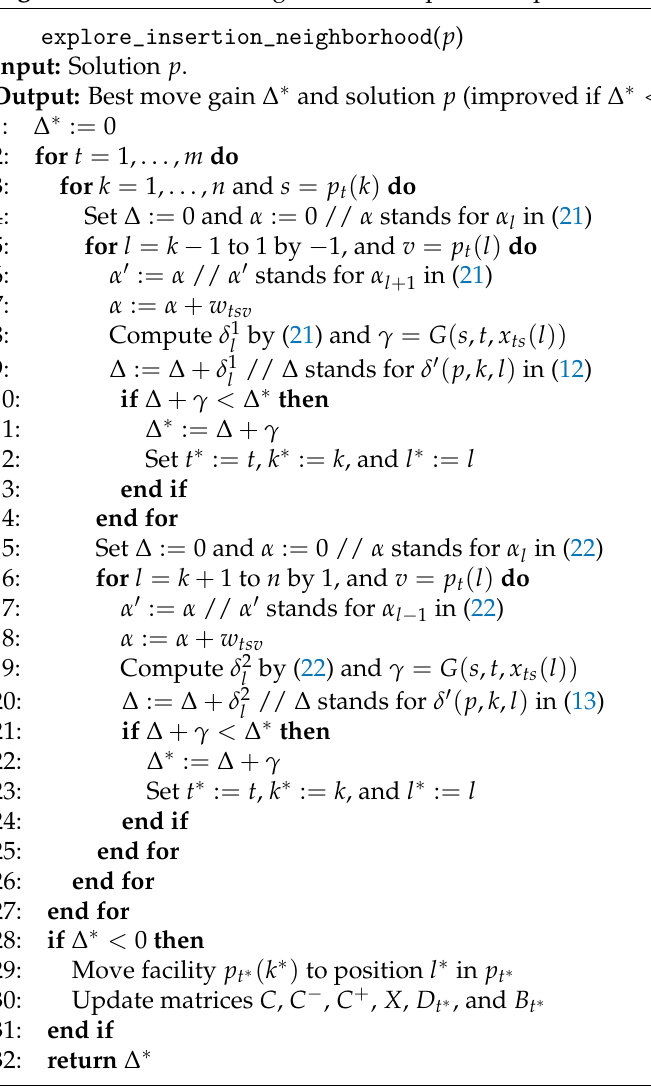
Algorithm 6 Insertion neighborhood exploration